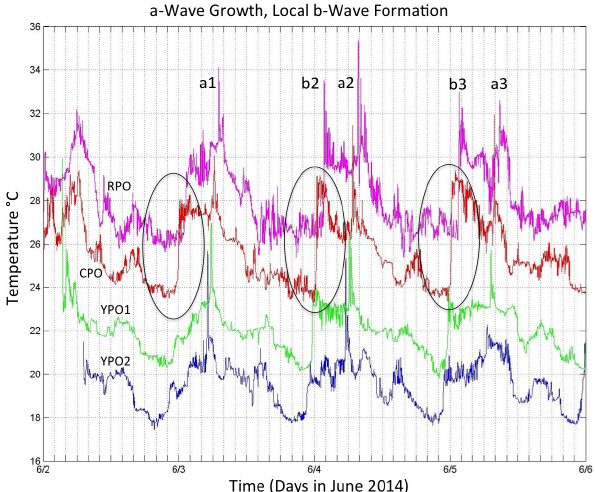
Figure 7. As in Fig. 6 except for 14–18